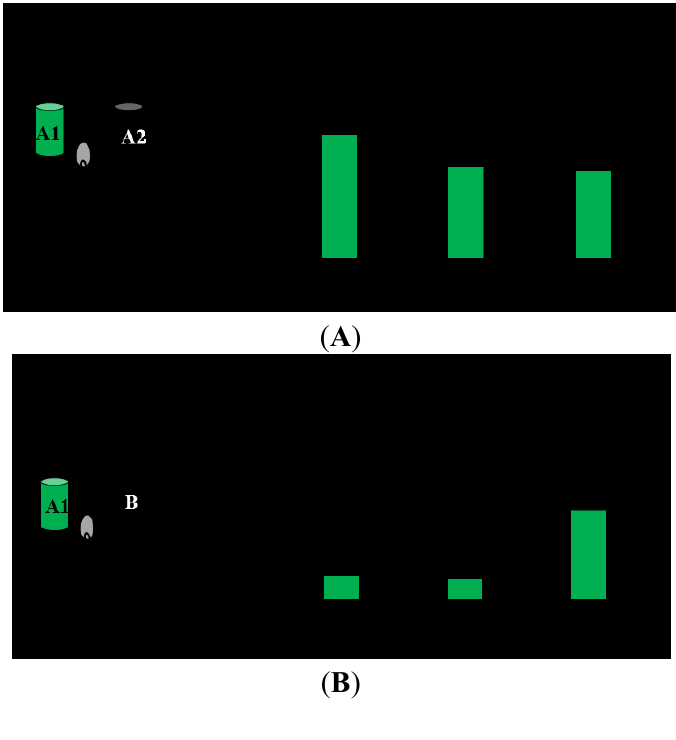
Figure 2. DE-SOA impaired novel object recognition ability after three months exposure. ( A ) Training phase, ( B ) test phase and ( C ) discrimination index in the control, DE and DE-SOA exposed mice. Each bar represents the mean ± SE. A1 and A2 are identical raccoon dog toys and B is bear